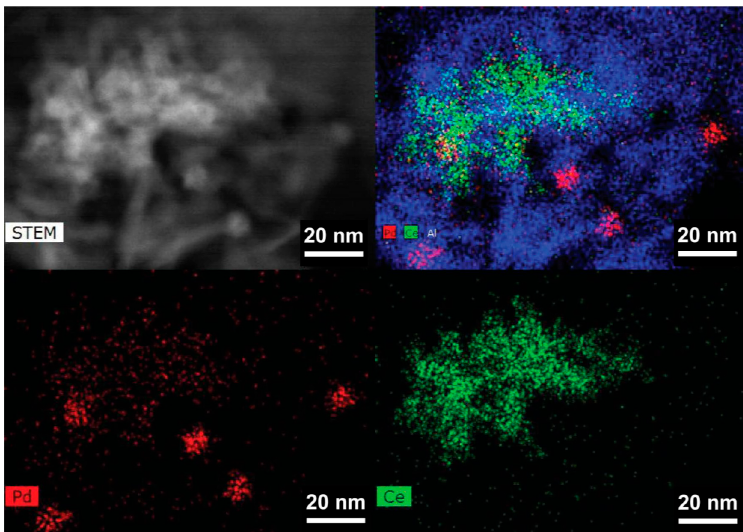
Figure 5. HAADF-STEM image and EDS mapping of 4Pd-20CeO 2 /Al 2 O ₃ catalyst (post reaction). ( top left ) STEM image; ( top right ) elementary distribution of Pd, Ce, Al overlapped together; ( bottom left ) EDS mapping to show elementary distribution of Pd; ( bottom right ) EDS mapping to show elementary distribution of Ce. Pd, Ce, and Al are color coded as red, green, and blue, respectively.